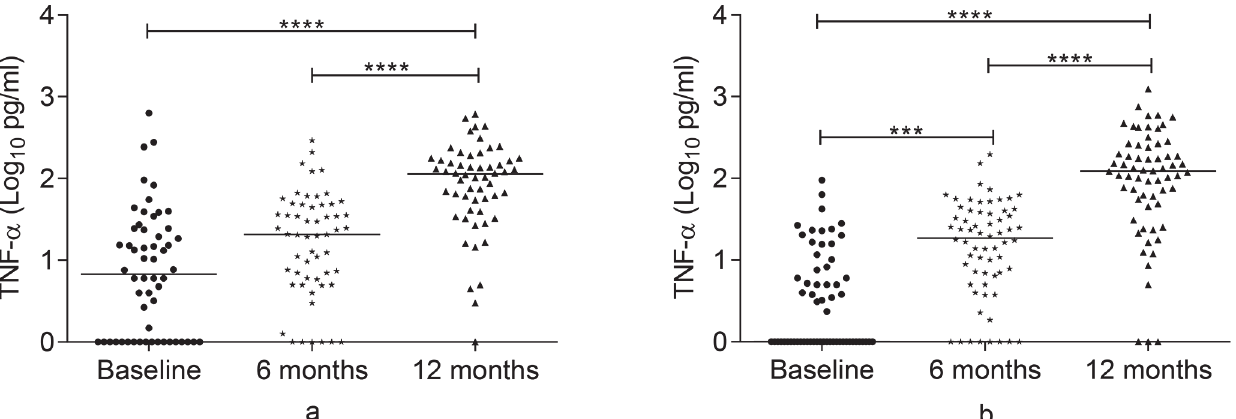
Fig 4. Changes in TNF- α response to Rv2031 over 12 months in patients and contacts. TNF- α response over 12 months in patients (a) and contacts (b) following whole blood stimulation with Rv2031 for 48 hours. Filled circles represent baseline levels, filled diamonds represent 6 month levels and filled triangles represent 12 month levels. Results are individual responses and cytokine levels are expressed as log 10 pg/ml. Horizontal bars are medians. Freidman test with Dunn ’ s multiple comparisons was used to compare TNF- α response over time. *** p < 0.001, **** p < 0.0001.